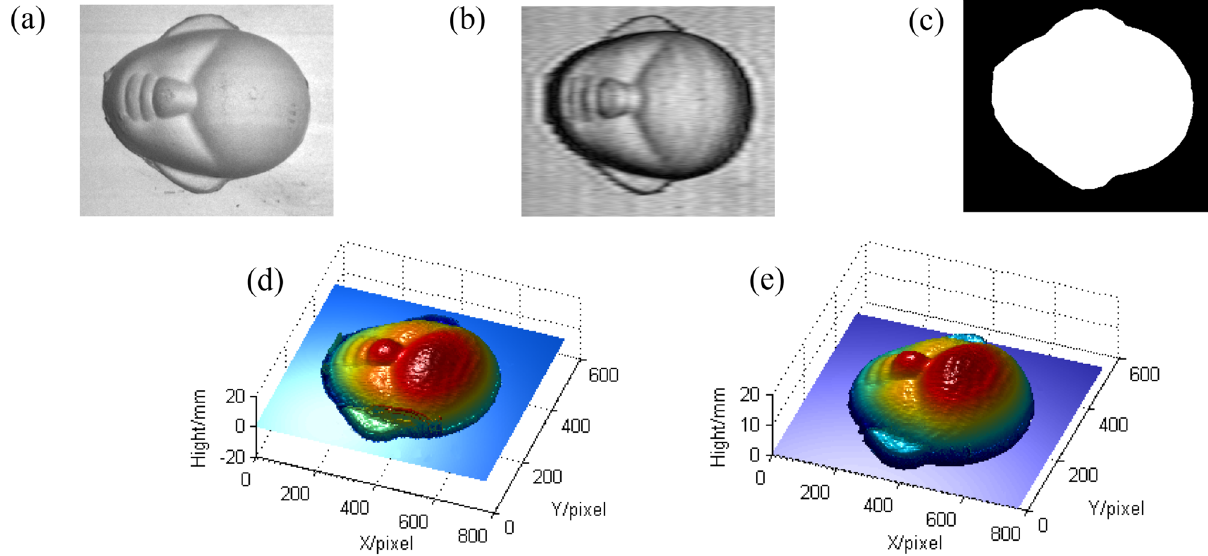
Figure 6. The comparison of reconstructed face models before and after using the mask: ( a ) the measured face; ( b ) the modulation; ( c ) the mask; ( d ) the reconstructed face before using the mask; ( e ) the reconstructed face after using the